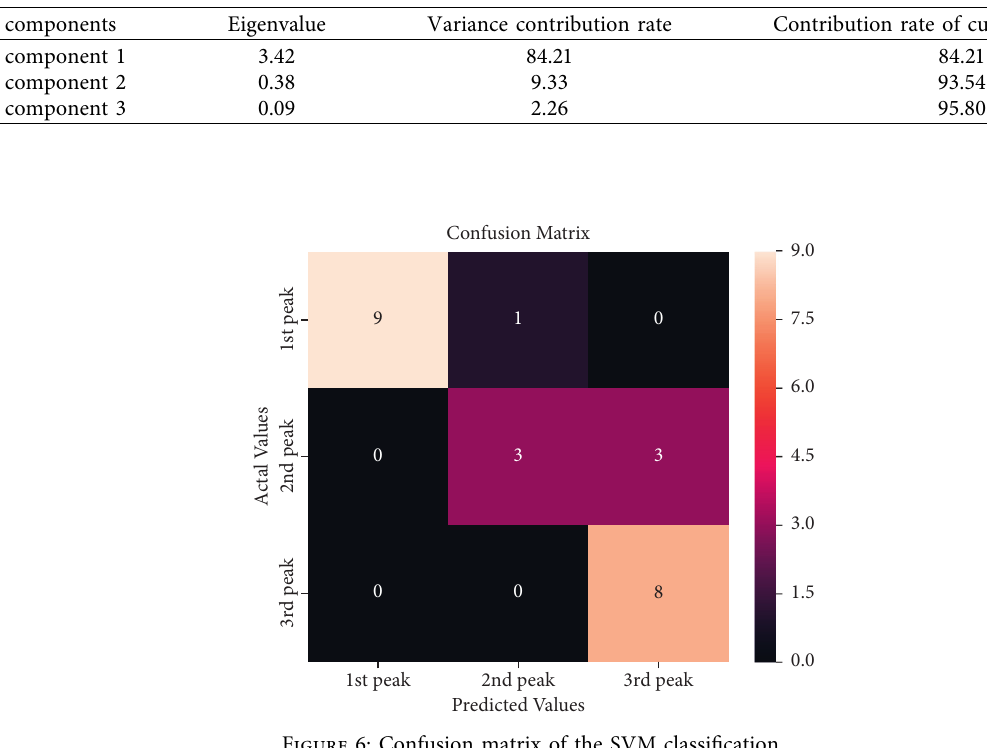
Figure 5: Classification of smell peaks. Table 4: Interpretation of total variance based on principal components.